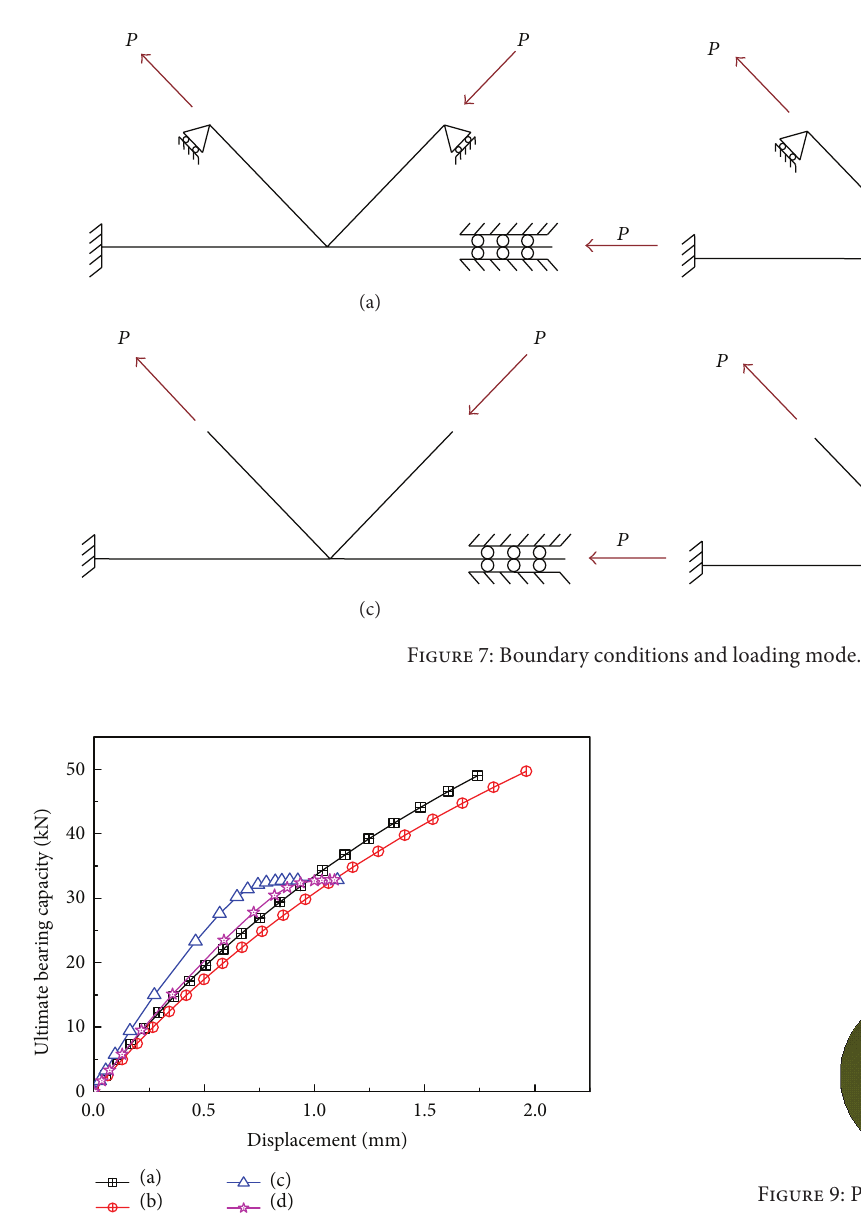
Figure 8: Loading-deformation curves in different boundary con- ditions.